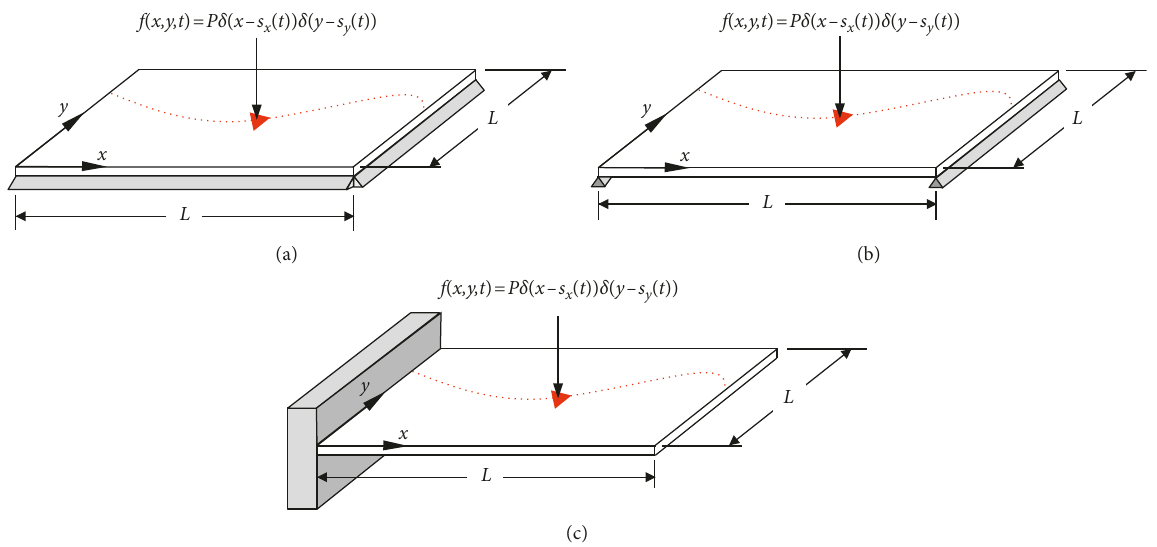
Figure 9: Three examples of square plates subjected to a moving point force P , where the red arrow indicates current position of the moving point force. (a) Example 1: S-S-S-S boundary condition. (b) Example 2: S-F-S-F boundary condition. (c) Example 3: C-F-F-F boundary condition.